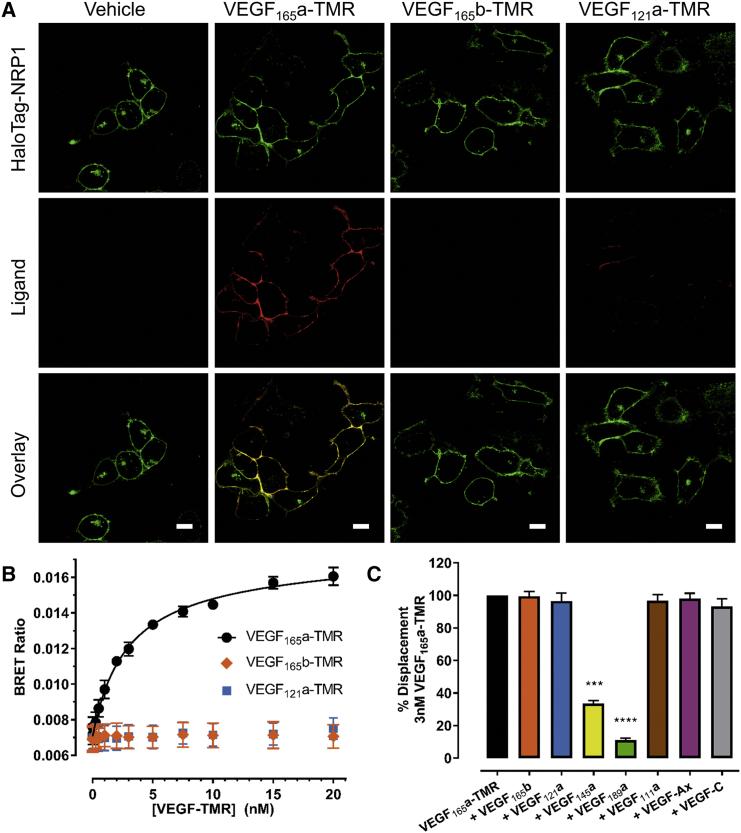
Selective Binding of VEGF Isoforms at NRP1(A) Confocal live cell imaging of fluorescently labeled VEGF-TMR isoforms binding to N-terminal HaloTag-NRP1 stably expressed in HEK293T cells. HaloTag-NRP1 was tagged with the membrane-impermeant HaloTag-AF488 dye (green) and then incubated with 10 nM VEGF165a-TMR, VEGF165b-TMR, or VEGF121a-TMR (red) for 60 min at 37°C. Cells were imaged using an LSM710 confocal microscope and images are representative of those obtained in 3 independent experiments. Scale bar, 10 μm.(B) NanoLuc-NRP1 HEK293T cells were incubated with increasing concentrations of VEGF165a-TMR, VEGF165b-TMR, or VEGF121a-TMR and incubated for 60 min at 37°C. Raw BRET ratios are expressed as mean ± SEM from 3–4 independent experiments.(C) Inhibition of VEGF165a-TMR (3 nM) by competing unlabeled VEGF isoforms (30 nM), added simultaneously and incubated for 60 min at 37°C. Data are normalized to 3 nM VEGF165a-TMR (100%, black bar) and represent mean ± SEM pooled from 5 independent experiments. Statistical analyses were performed using Welch's t test: ***p ≤ 0.001; ****p ≤ 0.0001.